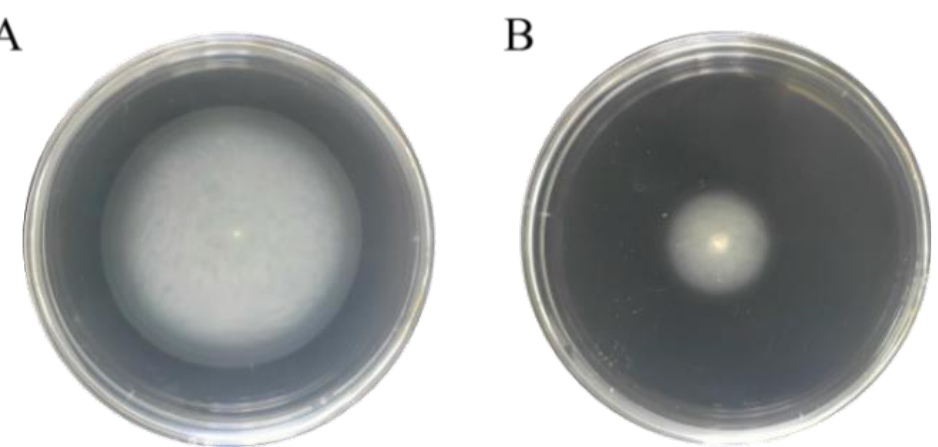
Figure 7. Effect of sodium hypochlorite on swimming motility of S . Enteritidis. ( A ) Control group (0 ppm sodium hypochlorite); ( B ) treated group (130 ppm sodium hypochlorite).